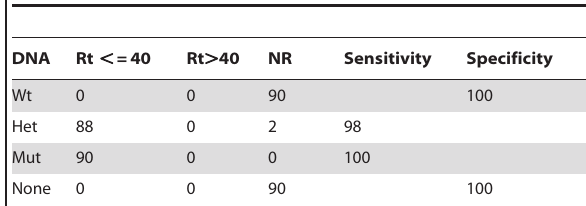
Table 2. Qualitative analysis of the results from the genomic DNAs vs Mt probes.